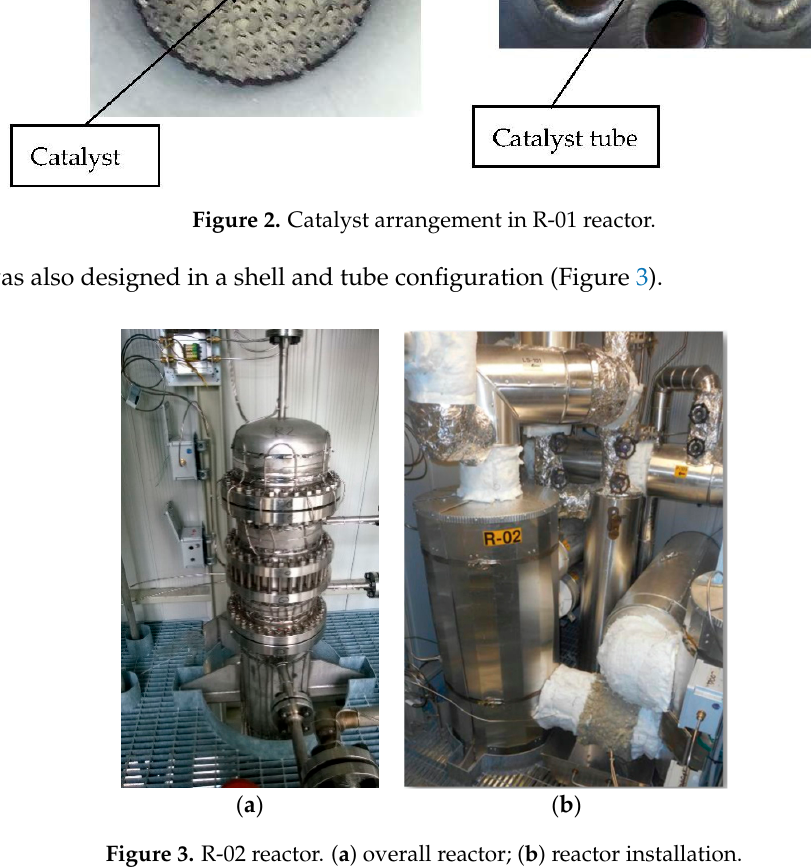
Figure 3. R-02 reactor. ( a ) overall reactor; ( b ) reactor installation.